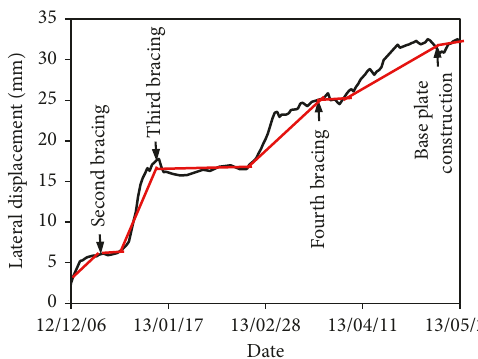
Figure 7: Time curves of lateral displacement of the diaphragm wall for measuring point CX9 at depth of